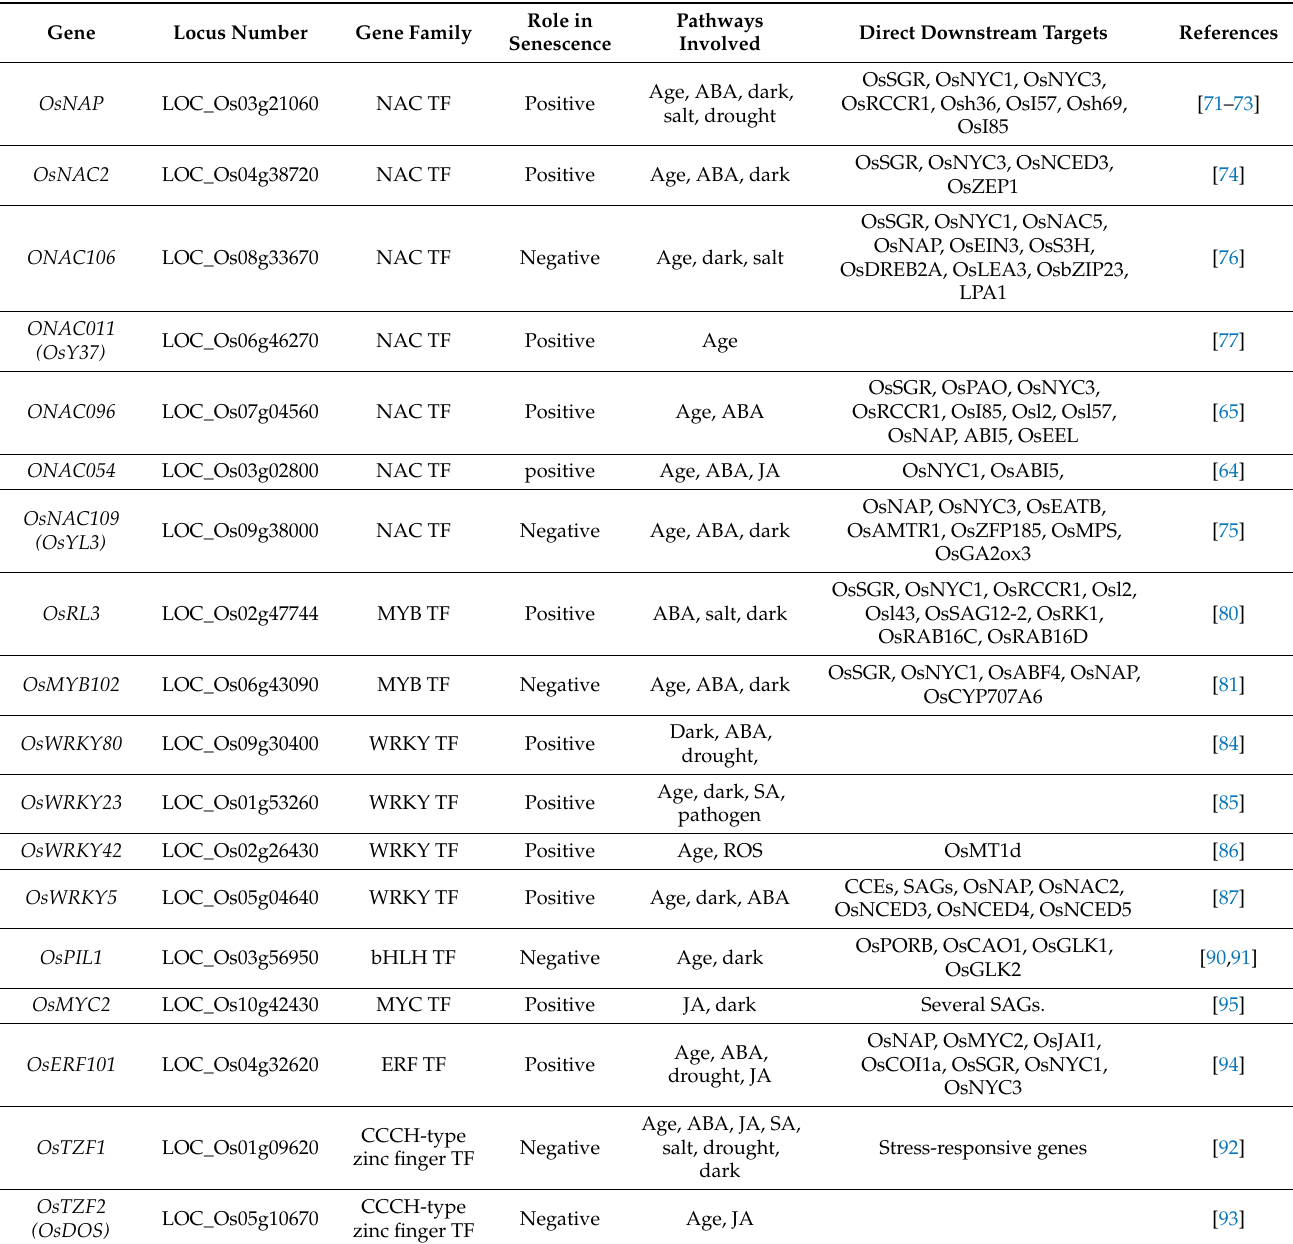
Table 1. Summary of transcription factors associated with rice leaf